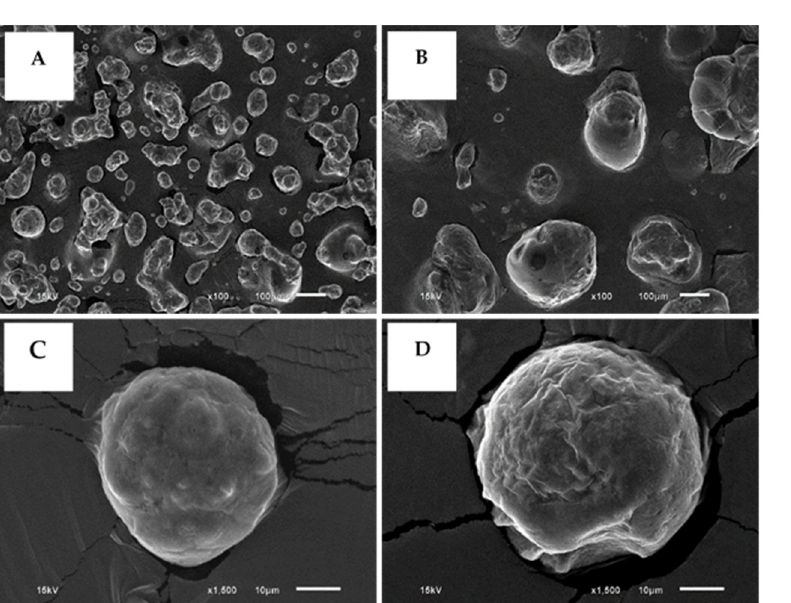
Different letters in the same row indicated significantly difference at p < 0.05. 1 Values are expressed as mean ± standard deviation.